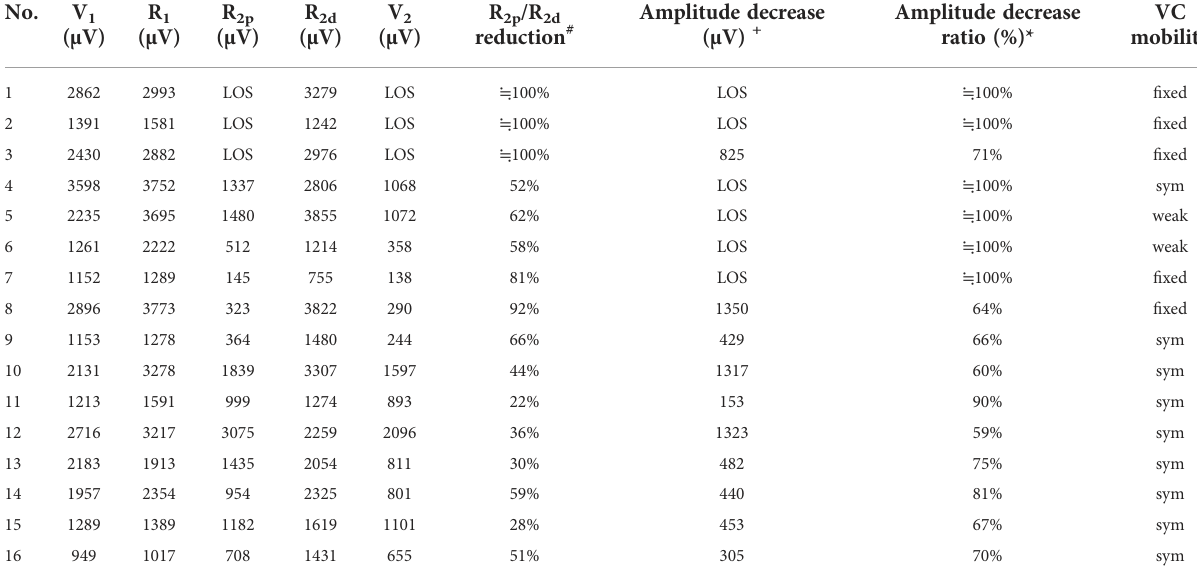
TABLE 2 Type B EMG recovery pattern (incomplete EMG recovery with an injury point detected on RLN). No.